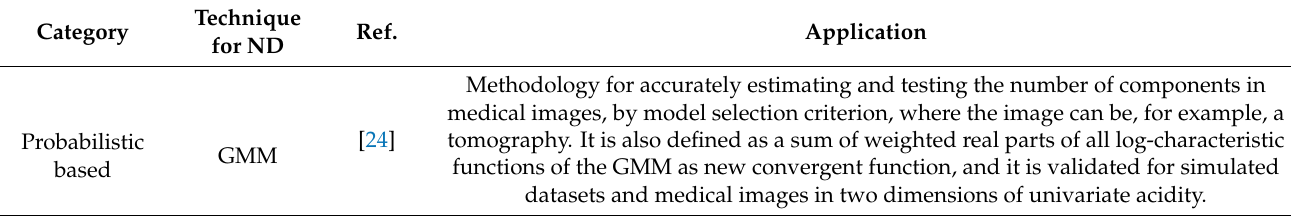
Table 1. Methodologies for ND according to the general